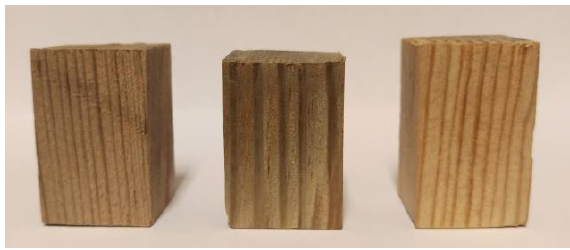
Figure 6. Samples prepared for scanning: “1”, “2” and “3” (from left to right).